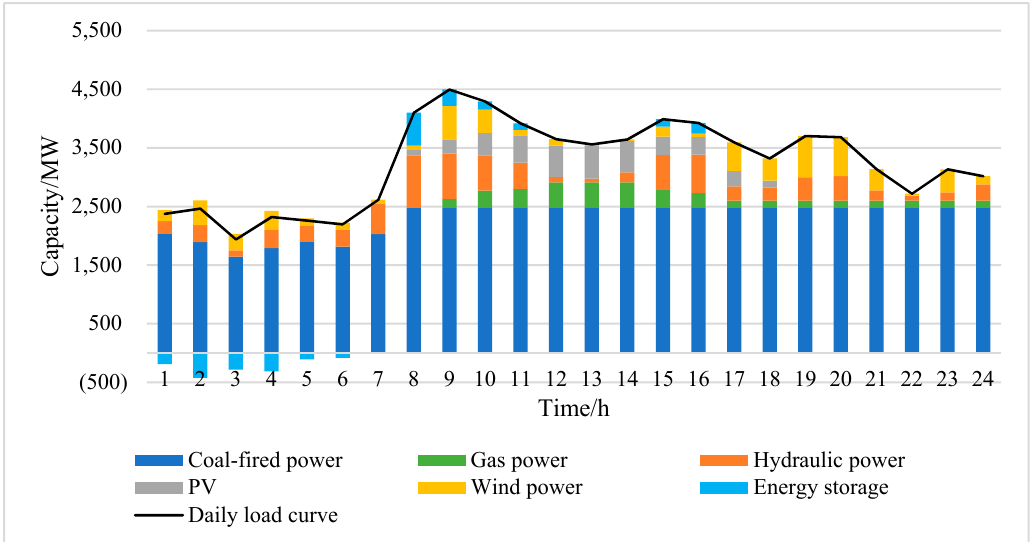
Figure 7. Energy output diagram of each type.